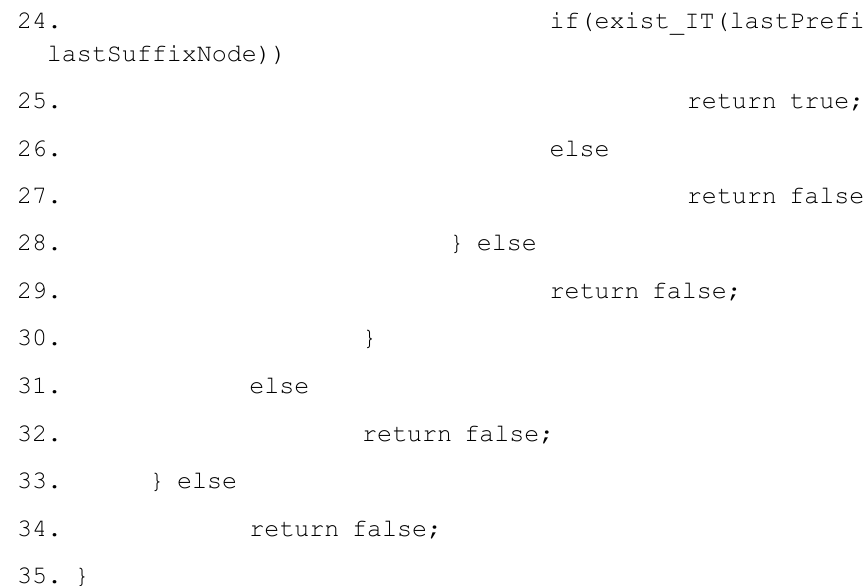
Algorithm 1 . Insertion and Search procedures in